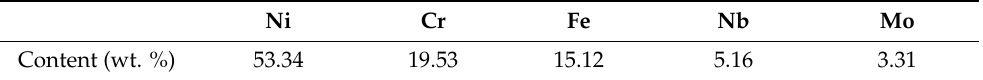
Table 1. Main chemical compositions of the investigated nickel-based superalloy. Ni Content (wt.